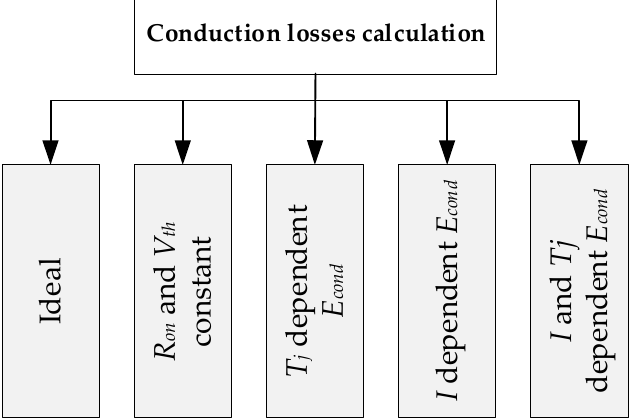
Figure 7. The considered five conduction power losses calculation variants.